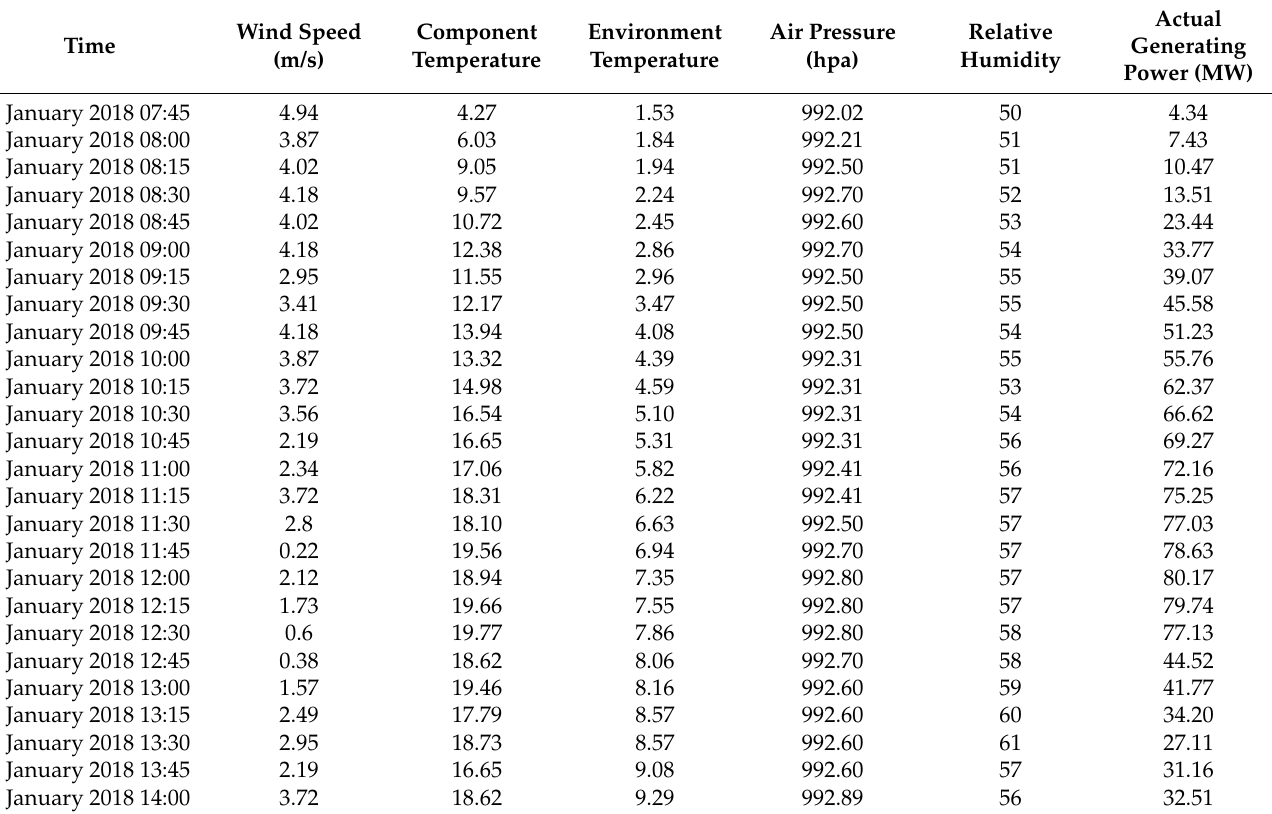
Table 1. Partial data sets of this